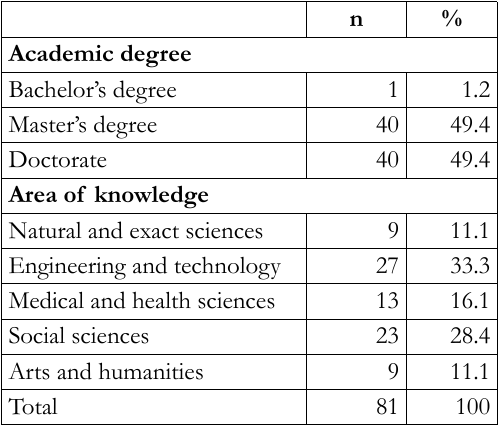
Table 1. Descriptive analysis of the